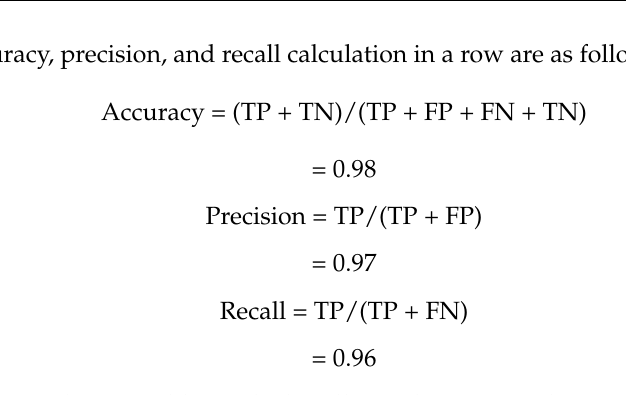
Table 6. Calculation TP, TN, FP, and FN in handling schema heterogeneity problem. A split-match-merge method with a multi-matcher algorithm